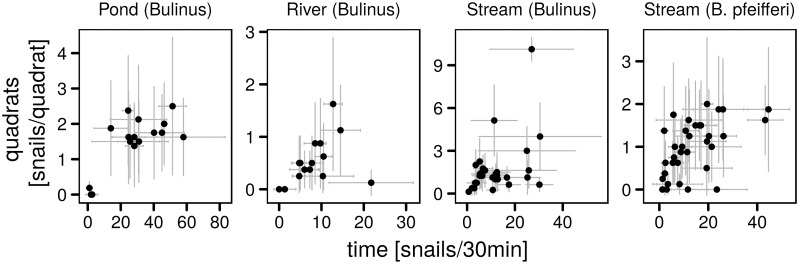
Comparison of monthly mean densities from the quadrat and time-based sampling schemes.Horizontal and vertical errorbars give the 95% CI of the time-based and quadrat-based means respectively.